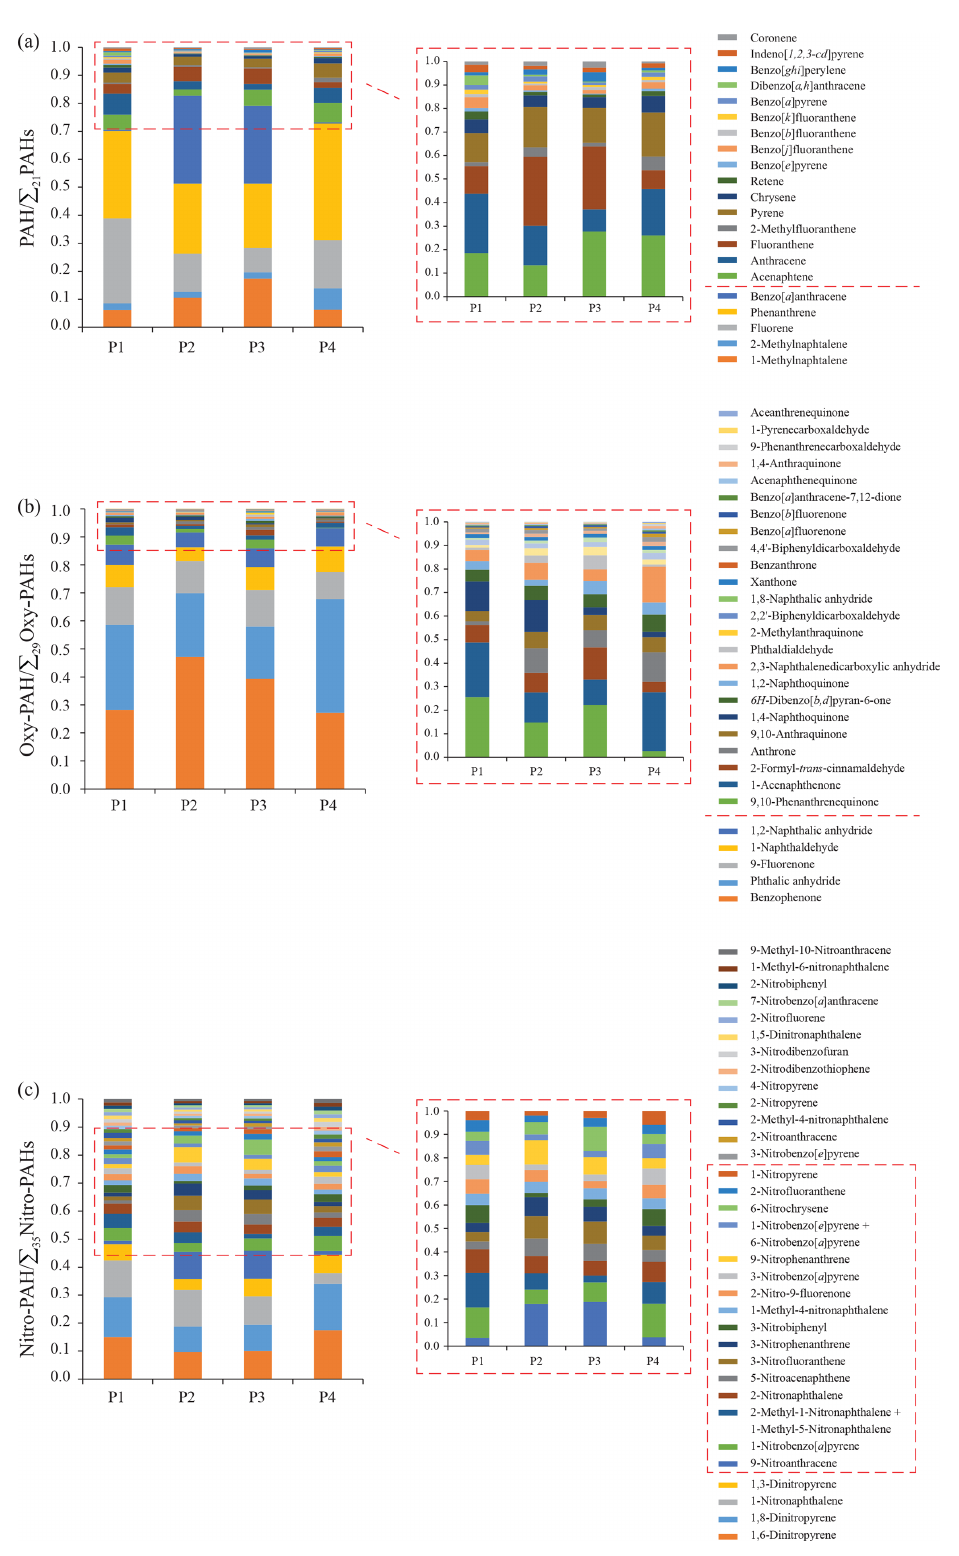
Figure 5. Average chemical profiles based on the total (gaseous + particulate phases) individual concentrations of PAHs (a) , oxy-PAHs (b) , and nitro-PAHs (c) for the November–January (P1; n = 8), February (P2; n = 4), March–April (P3; n = 7), and May–June (P4; n = 12) periods. Further details can be found in the Supplement (Fig.